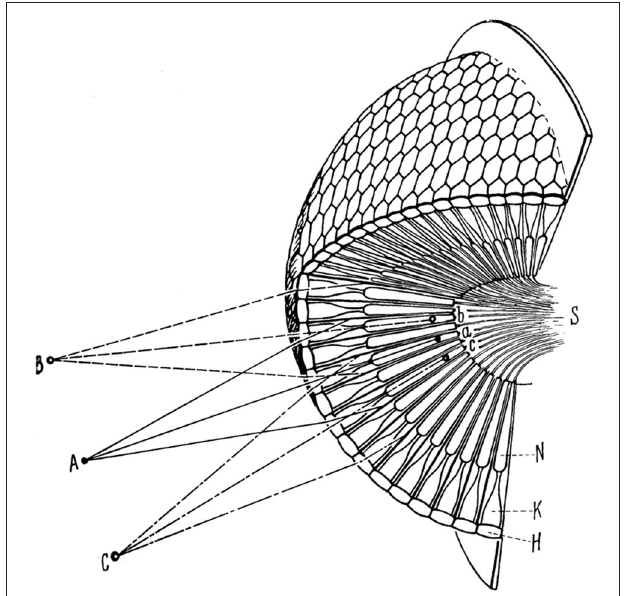
FIGURE 1 | Scheme of an apposition compound eye. The object points A, B, C in the environment correspond to the points a, b, c in the ommatidia. H, cornea; K, crystalline cone; N, receptor cell; S, optic nerve. Cf. Figure 3 left. Reprinted by permission from Springer Nature (Karl von Frisch, Aus dem Leben der Bienen) © Frisch